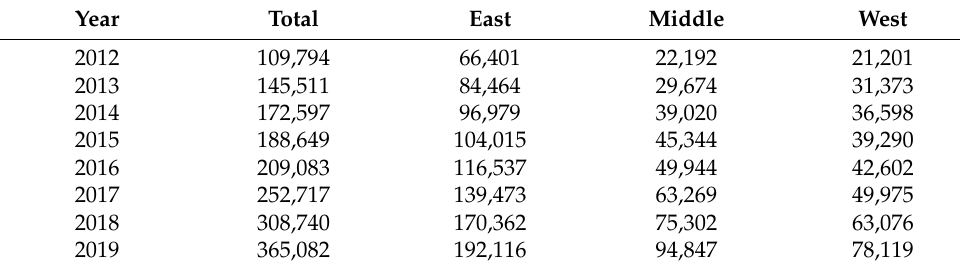
Table 1. Number of GPs in 2012–2019 in China.